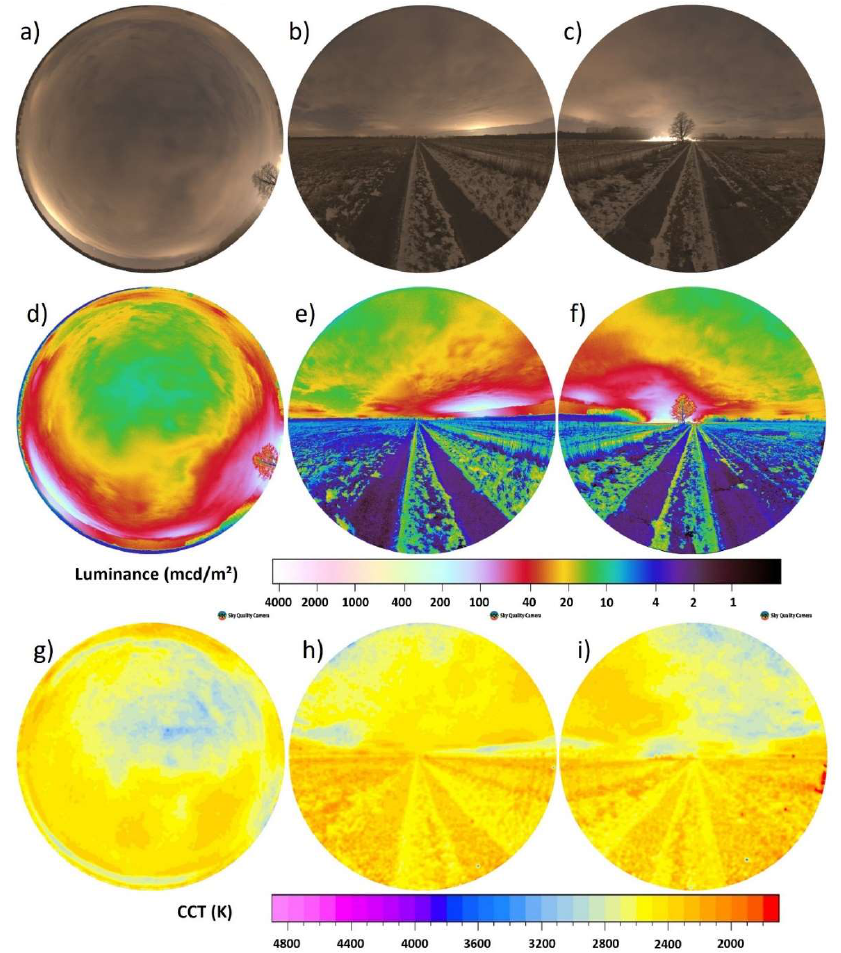
Figure 6. Imaging data taken during an overcast night in winter in the International Dark Sky Park Westhavelland in Germany near an experimental field site. The upper row ( a – c ) shows the RGB images, the center row ( d – f ) the calculated luminance maps and the lower row ( g – i ) the calculated CCT maps. The left column ( a , d , g ) shows the all-sky data the middle ( b , e , h ) and right ( c , f , i ) columns the vertical plane data.